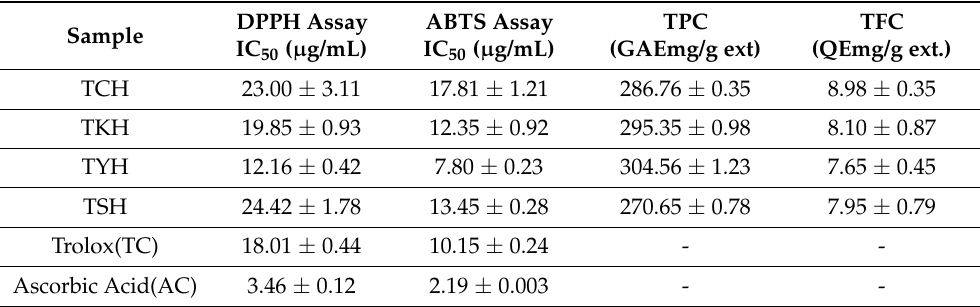
Table 3. Antioxidant activity of four T. chebula fruits from different geographical regions of Manipur, India.